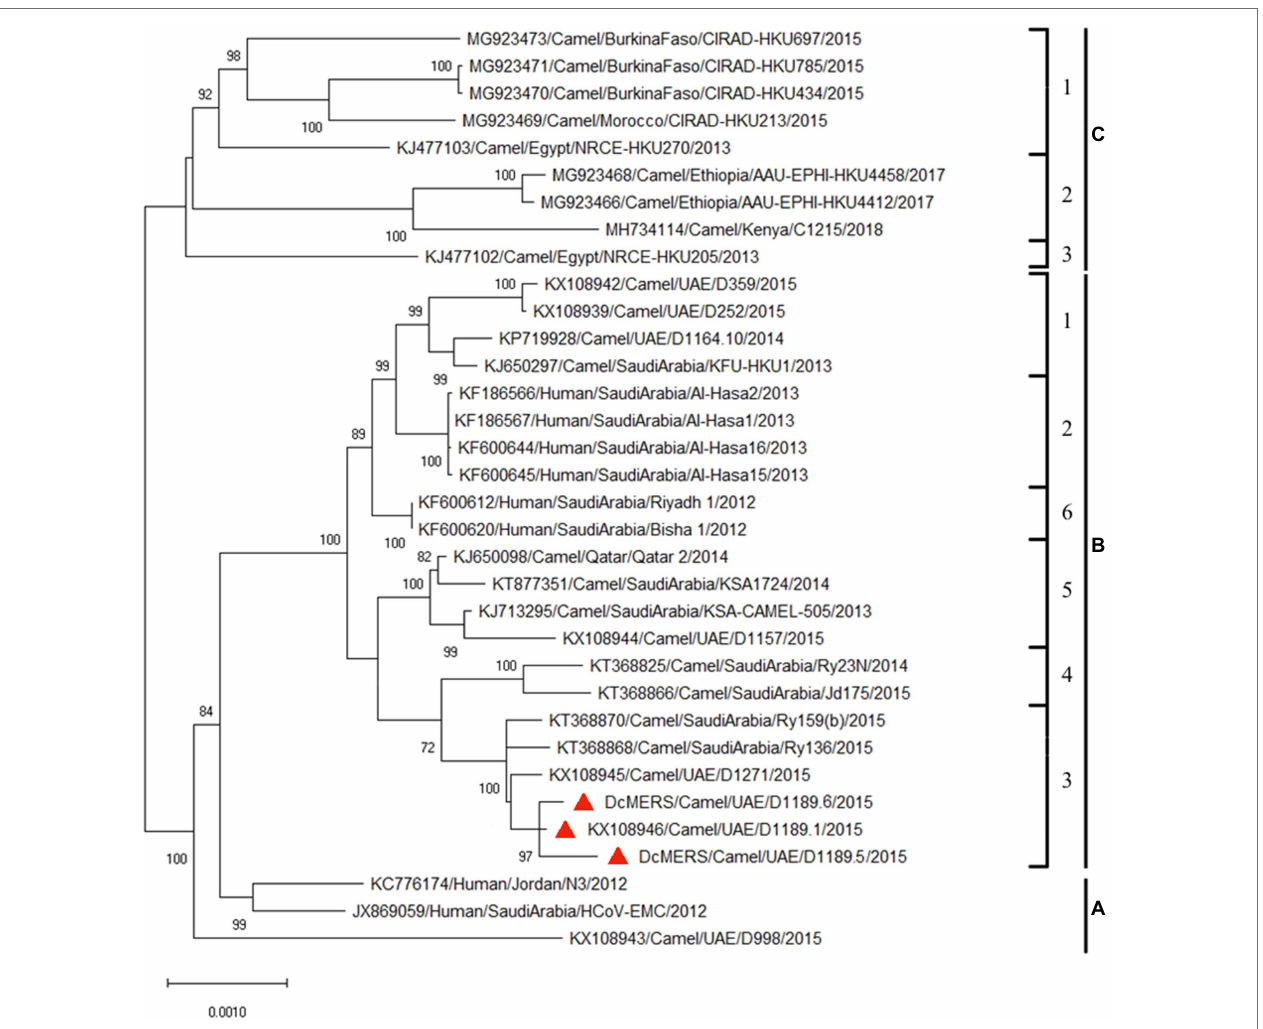
FIGURE 2 | Maximum-likelihood phylogeny based on the complete genome sequences of the three isolated dromedary Middle East respiratory syndrome coronavirus (MERS-CoV) strains (D1189.1, D1189.5, and D1189.6) and those of other closely related MERS-CoV strains. Phylogenetic tree was generated using the TN93 model and a discrete Gamma distribution with 1,000 bootstrap pseudoreplicates. Thirty thousand three hundred thirty nucleotide positions of the complete genome were included in the analyses. The tree with the highest log likelihood ( − 48750.09) is shown. Bootstrap values are shown next to the branches. The scale bar indicates the number of nucleotide substitutions per site. The three MERS-CoV strains sequenced and analyzed in the present study are shown in red triangular. All the accession numbers are given as cited in